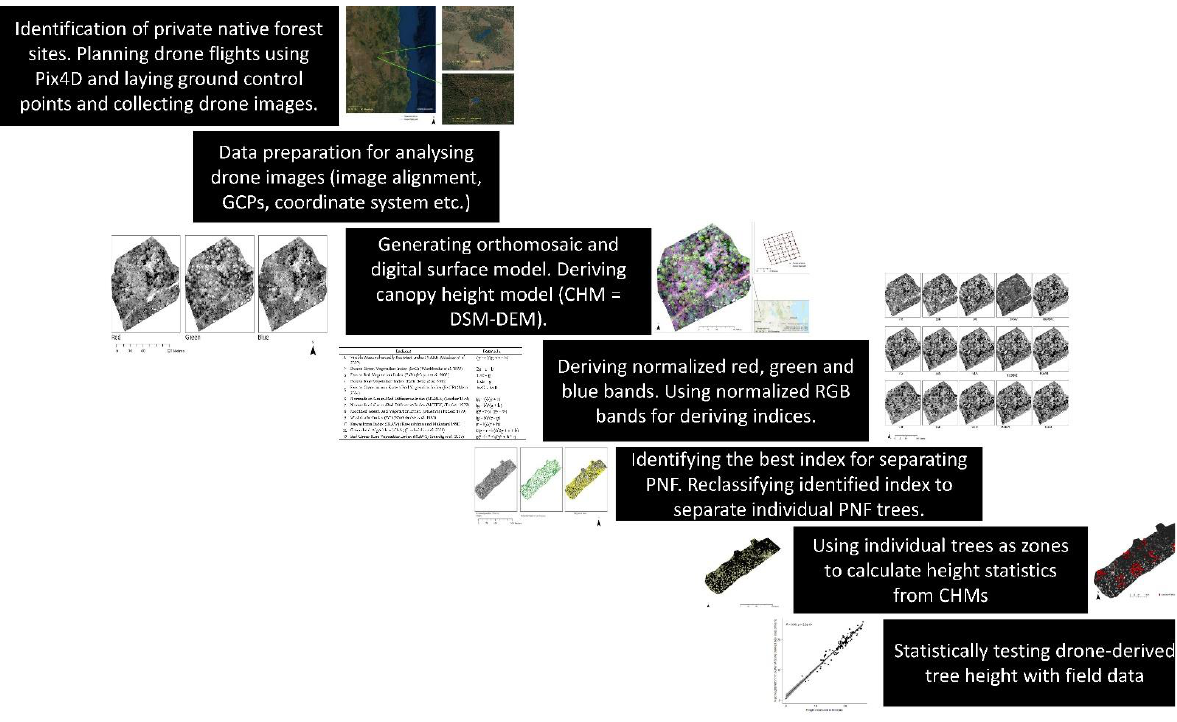
Figure 2. Methodological framework used in this study.